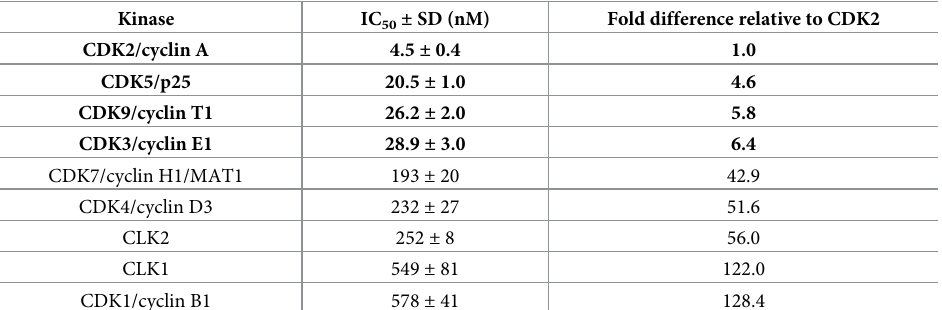
Table 1. CDK inhibitory potency and selectivity of fadraciclib (CYC065). IC 50 values determined from a 9-point concentration curve at around K m [ATP] (Carna Biosciences). The most potently inhibited kinases (IC 50 < 30nM) are highlighted in